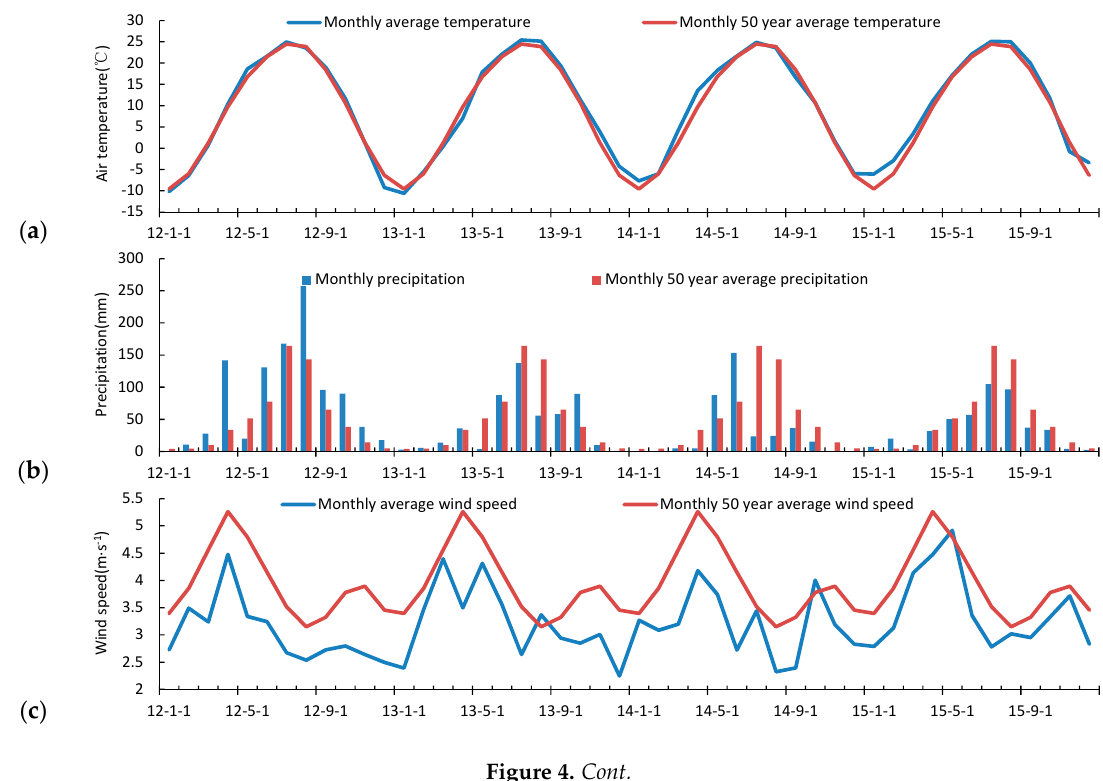
Table 3. Meteorological factors and 50-year average comparison for